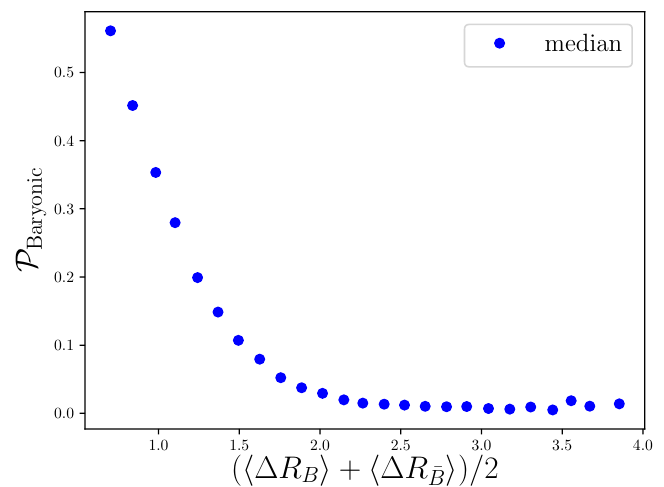
Figure 8 . Median values for the baryonic reconnection probability with respect to ( h (cid:1) R B i + h (cid:1) R (cid:22) i ) = 2 of the baryonic clusters for 3 cluster B